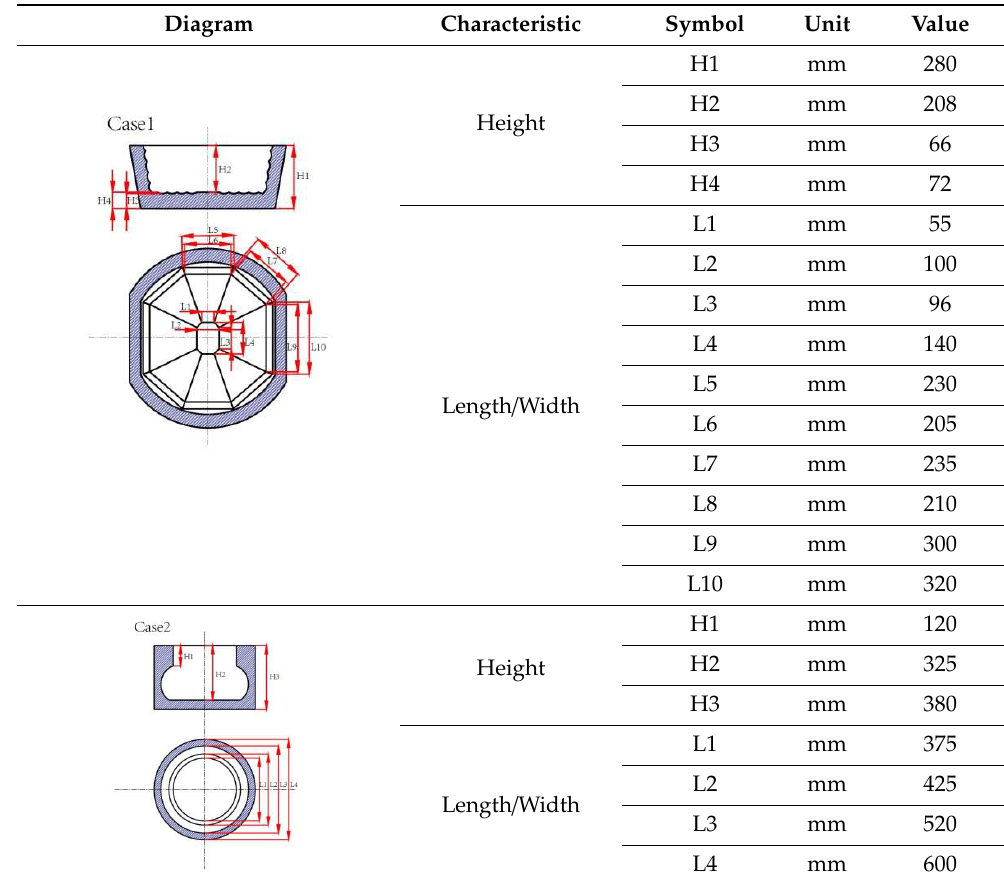
Table 2. The basic structure and parameters of different turbulence inhibitors. Figure 3. The details of the numerical simulation process. Diagram